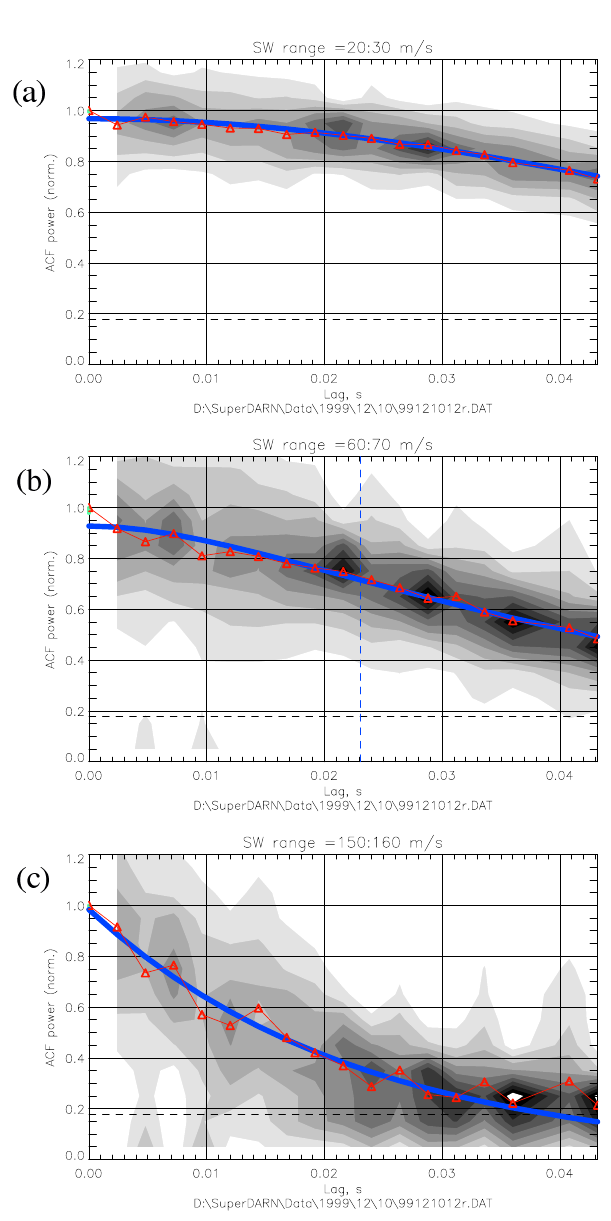
Fig. 13. Median normalised ACF power (red triangles) and the fit to Eq. (2) (blue line). Grey-scale contours show the spread of nor- malised distribution functions for each lag. Panels (a) , (b) and (c) correspond to low (W = 20–30m/s), medium (W = 60–70m/s) and high (W = 150–160m/s) spectral width, respectively.. The vertical dashed line in Fig. 13(b) identifies the transition from a Gaussian to exponential shape at τ = 2 T L (see text for details). The horizontal dashed line corresponds to the fluctuation level, σ R